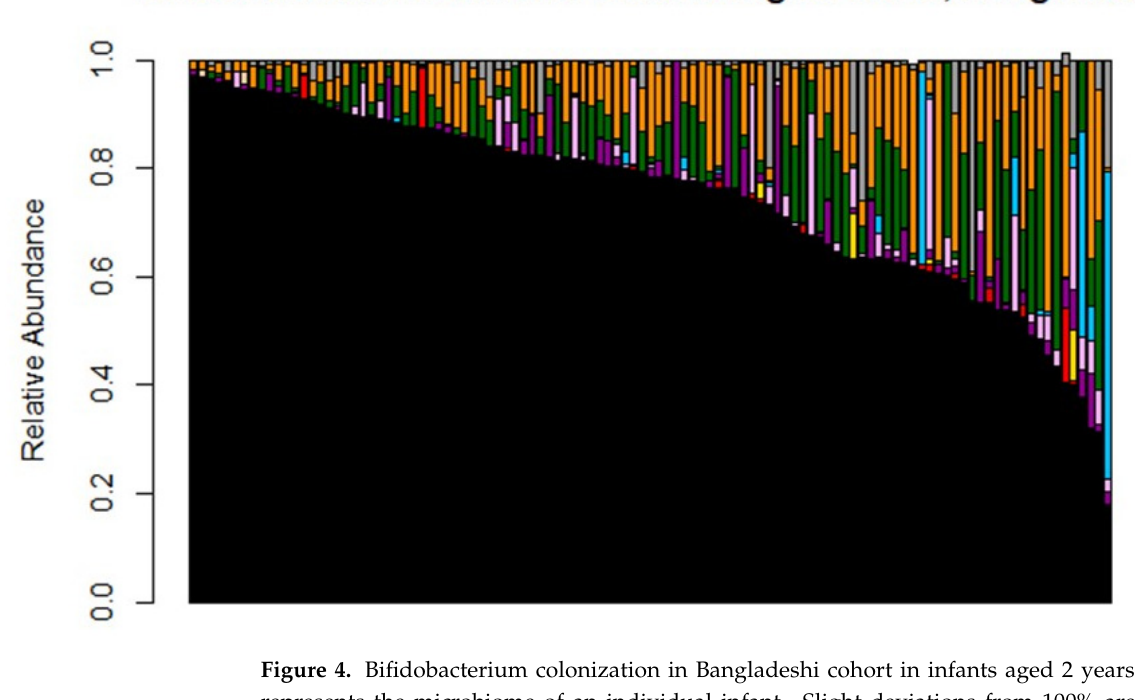
Figure 4. Bifidobacterium colonization in Bangladeshi cohort in infants aged 2 years. Each bar represents the microbiome of an individual infant. Slight deviations from 100% are related to rounding errors in the Bif-TRFLP calculation of percentages. Note the reduced prevalence of B. longum subspecies infantis in blue; this is a subset of the same infants shown in Figure 2B. Table 4. Table of number of European infants colonized at any level by B. longum subsp. infantis at 1 year of age by breastfeeding status. Prevalence of B. longum subsp. infantis appears to decrease rapidly during the weaning period, supporting the assumption that vertical transmission will be